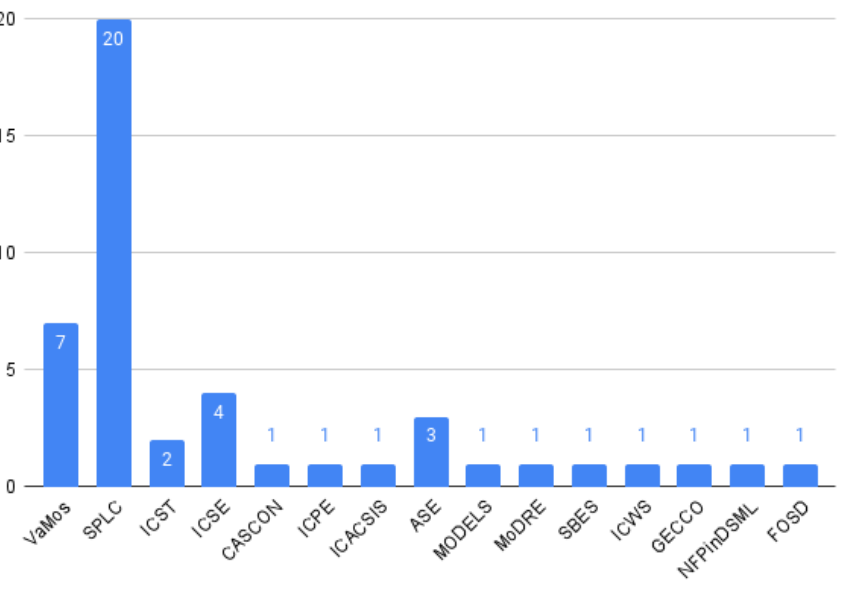
Figure 15. Papers published in